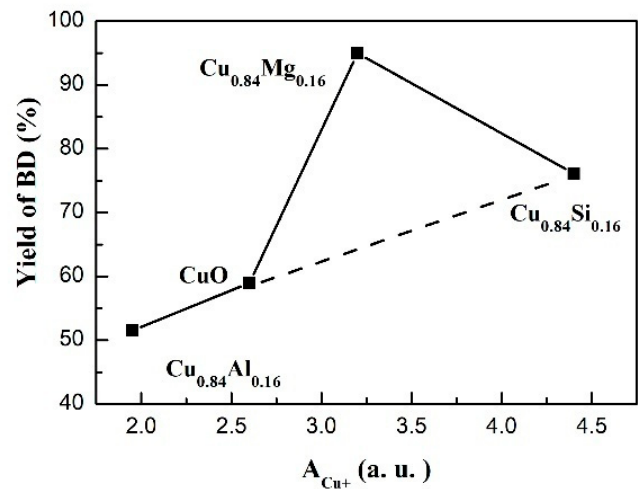
Figure 13. The BD yield of catalysts after 15 h as a function of the integrated area of the Cu + peak (A Cu+ ) determined by CO-IR spectroscopy.